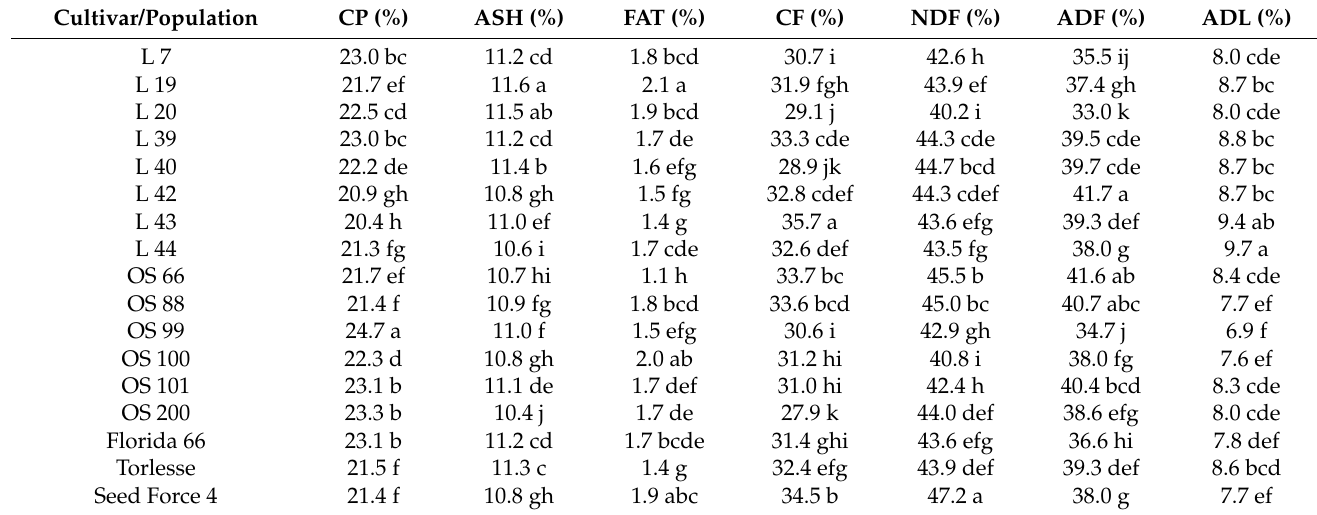
Table 1. Mean values of forage nutritive quality traits in alfalfa expressed in dry matter